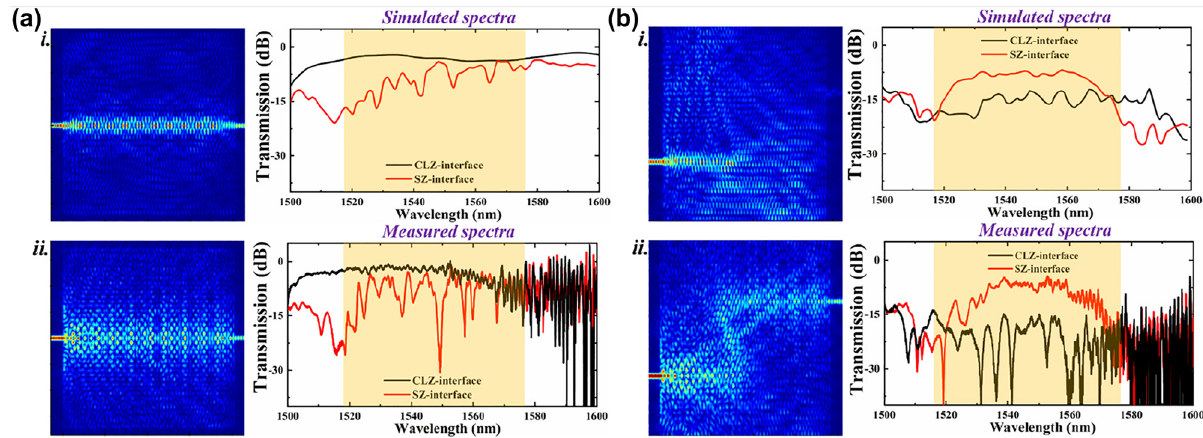
Figure 4: Experimental demonstrations of the optical transports along the domain walls formed by the SZ- and CLZ-interfaces. (a) The simulated electric field distributions in the straight domain walls constructed by the (i) CLZ- and (ii) SZ-interfaces at 1550 nm (left). Simulated as well as measured transmission curves for the straight domain walls formed by the (i) CLZ- and (ii) SZ-interfaces (right). (b) The simulated electric field distributions in the Z-type domain walls constructed by the (i) CLZ- and (ii) SZ-interfaces at 1550 nm (left). Simulated as well as measured transmission curves for the Z-type domain walls formed by the (i) CLZ- and (ii) SZ-interfaces (right). Yellow region: photonic bandgap at the K / K ′